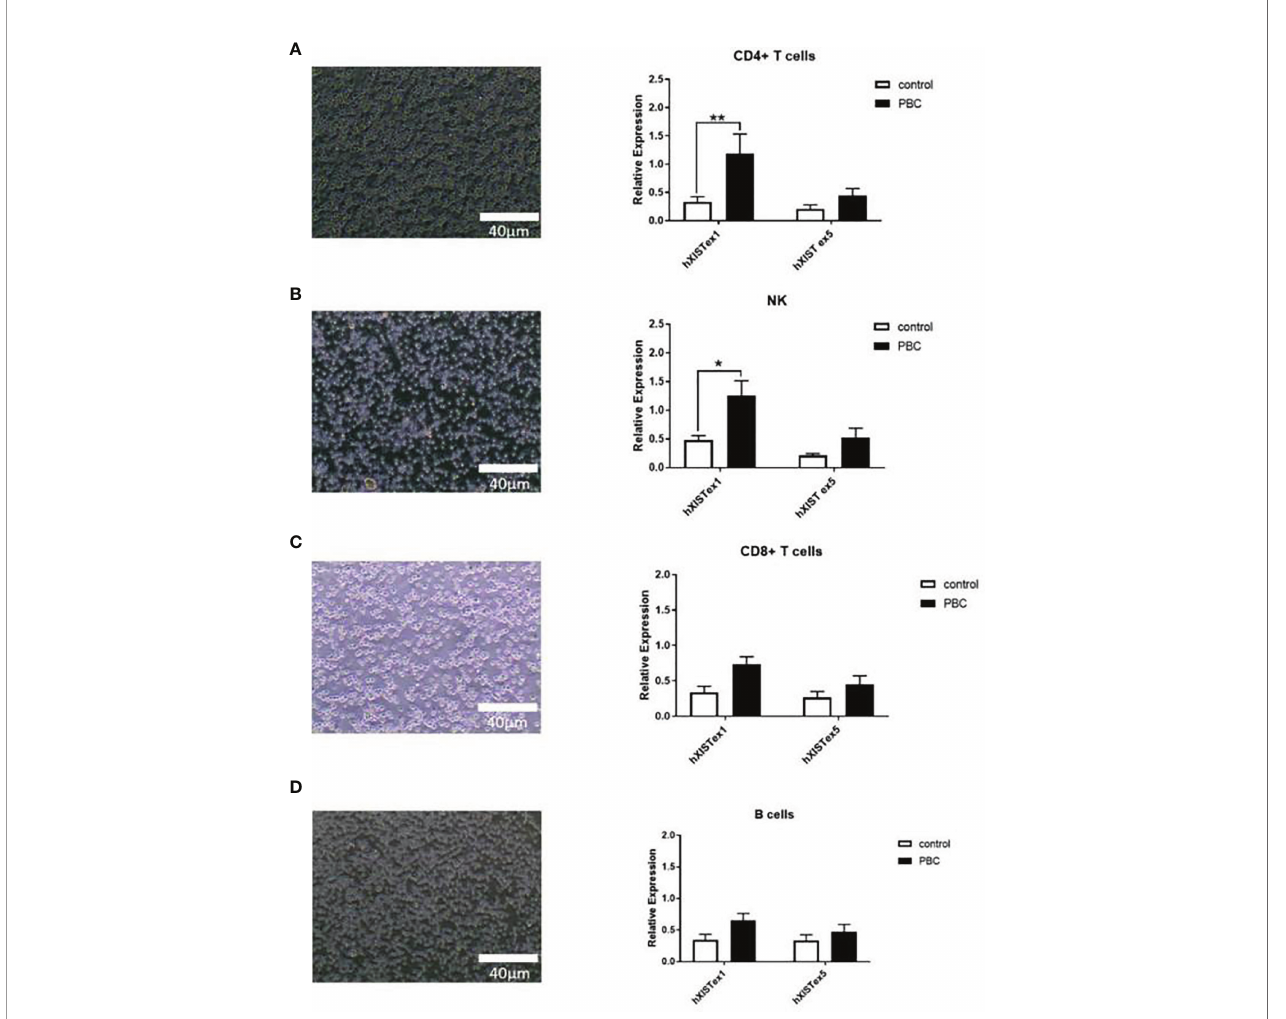
FIGURE 1 | Differential expression of LncRNA XIST in immune cells of PBC patients. Representative images (left, under electron microscope) and qRT-PCR (right) showing expression levels of LncRNA XIST in CD4+ T cells (A) , NK cells (B) , CD8+ T cells (C) and B cells (D) from PBC patients (n=20) and healthy controls (n=20). Results presented as mean ± SEM *signi fi cantly higher than control. (*p < 0.05; **p <